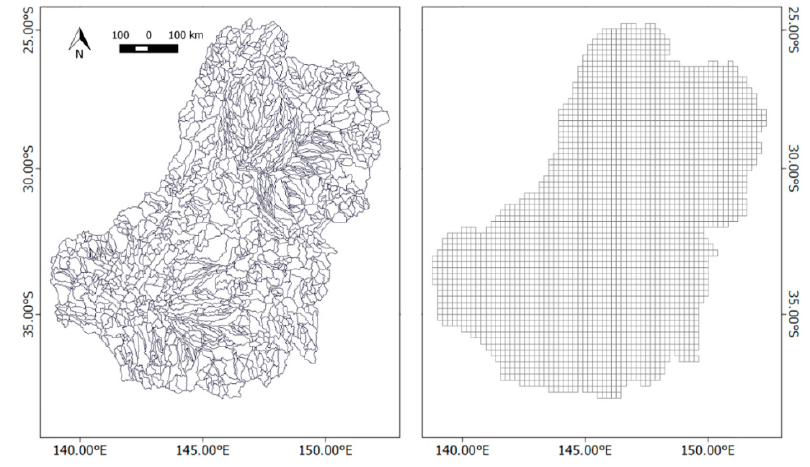
Figure A1. HydroBASINS Pfafstetter level 8 catchments and regular ~20 ˆ 20 km